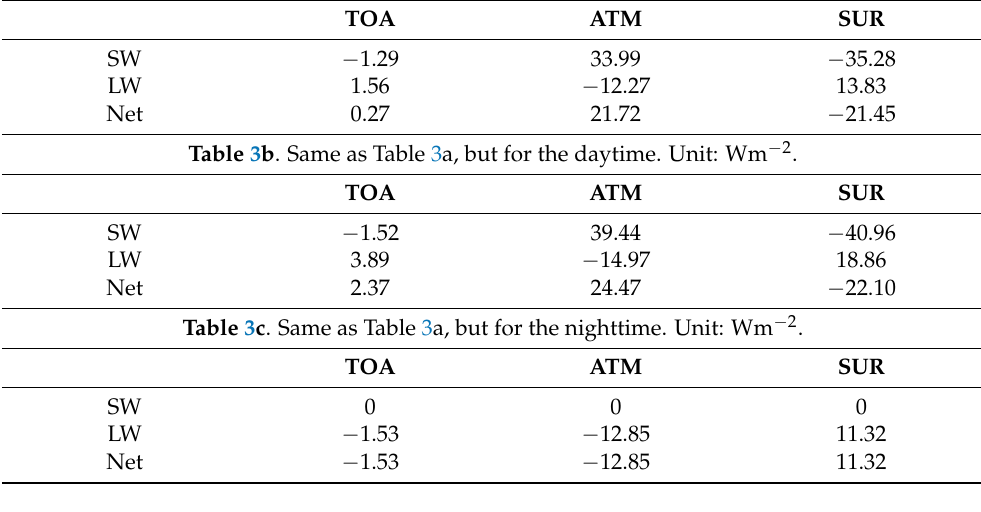
Table 3. The mean SW, LW, and net (SW + LW) DDREs (W m − 2 ) within the TB at the top of the atmosphere (TOA), at the surface (SUR), and in the atmosphere (ATM) during the selected dust storm, the daytime and the nighttime, respectively.